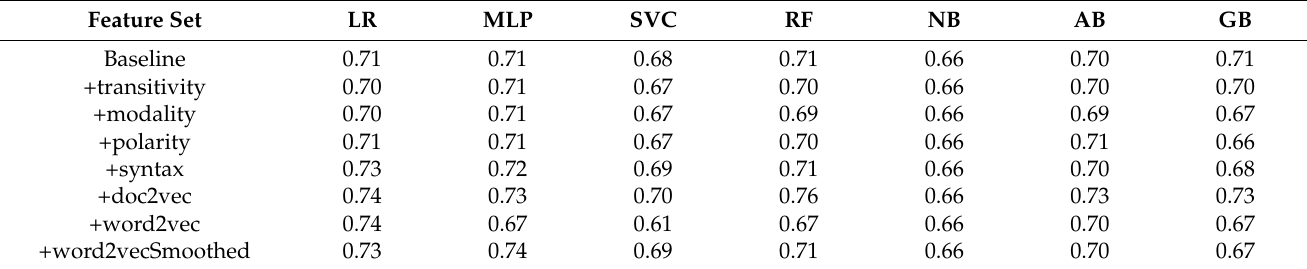
Table 3. Classification of problems from non-problems using ML classifiers by 10-fold cross validation.